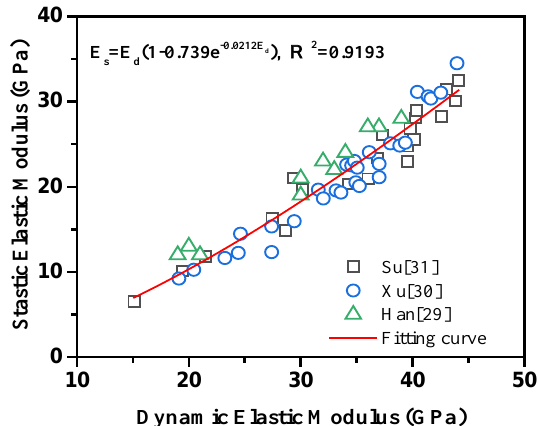
Figure 5. The relationship between static elastic modulus and dynamic elastic modulus of